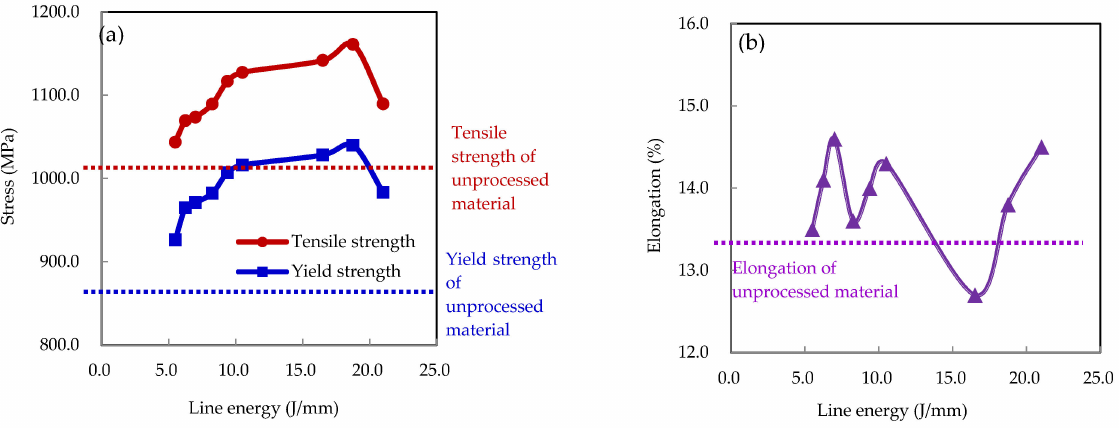
Figure 7. Monotonic tensile properties under different line energies: ( a ) yield strength and tensile strength; ( b )